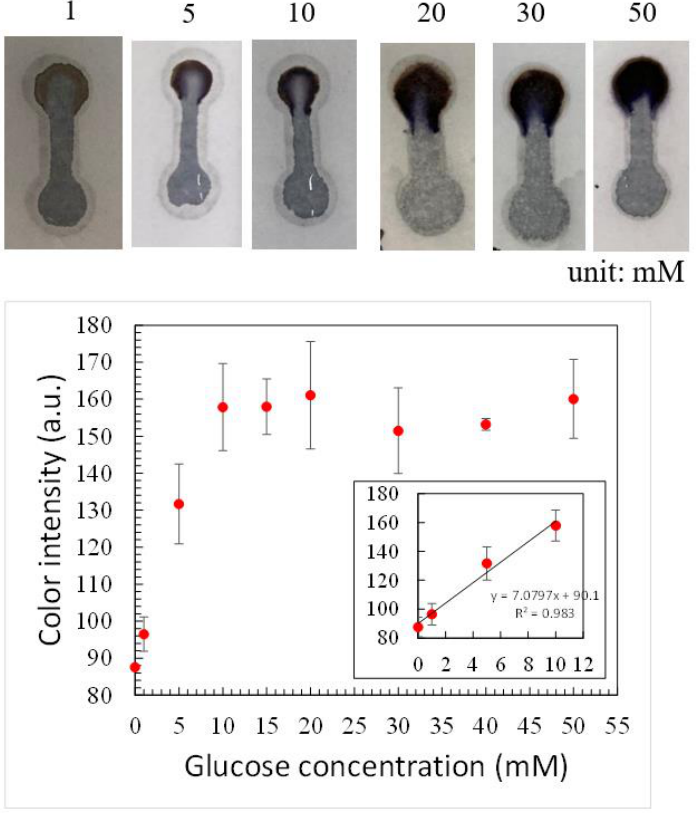
Figure 10. The color intensity for different glucose concentrations.